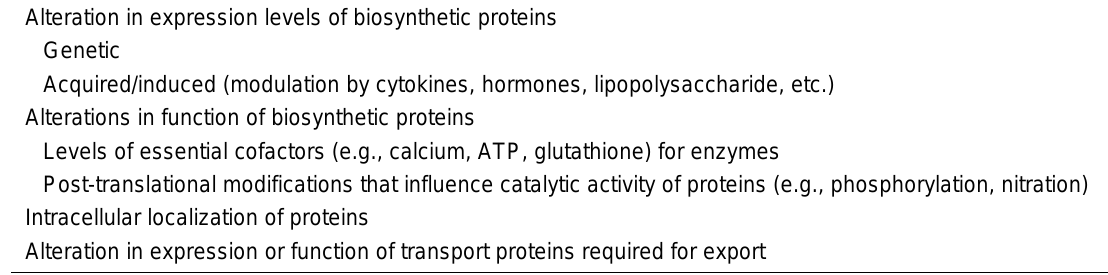
Mechanisms for the Regulation of Eicosanoid Biosynthesis and Secretion Alteration in expression levels of biosynthetic proteins Genetic Alterations in function of biosynthetic